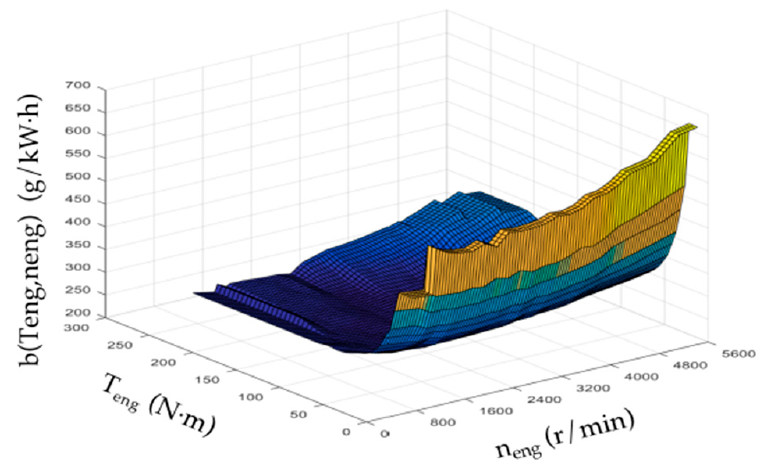
Figure 3. The engine fuel consumption